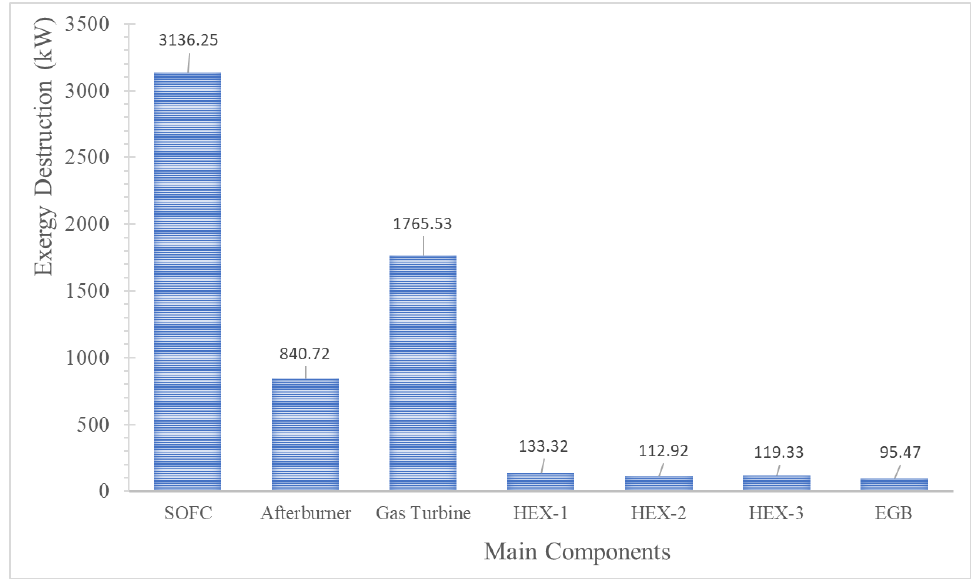
Figure 3. Exergy destruction of the main components of the proposed